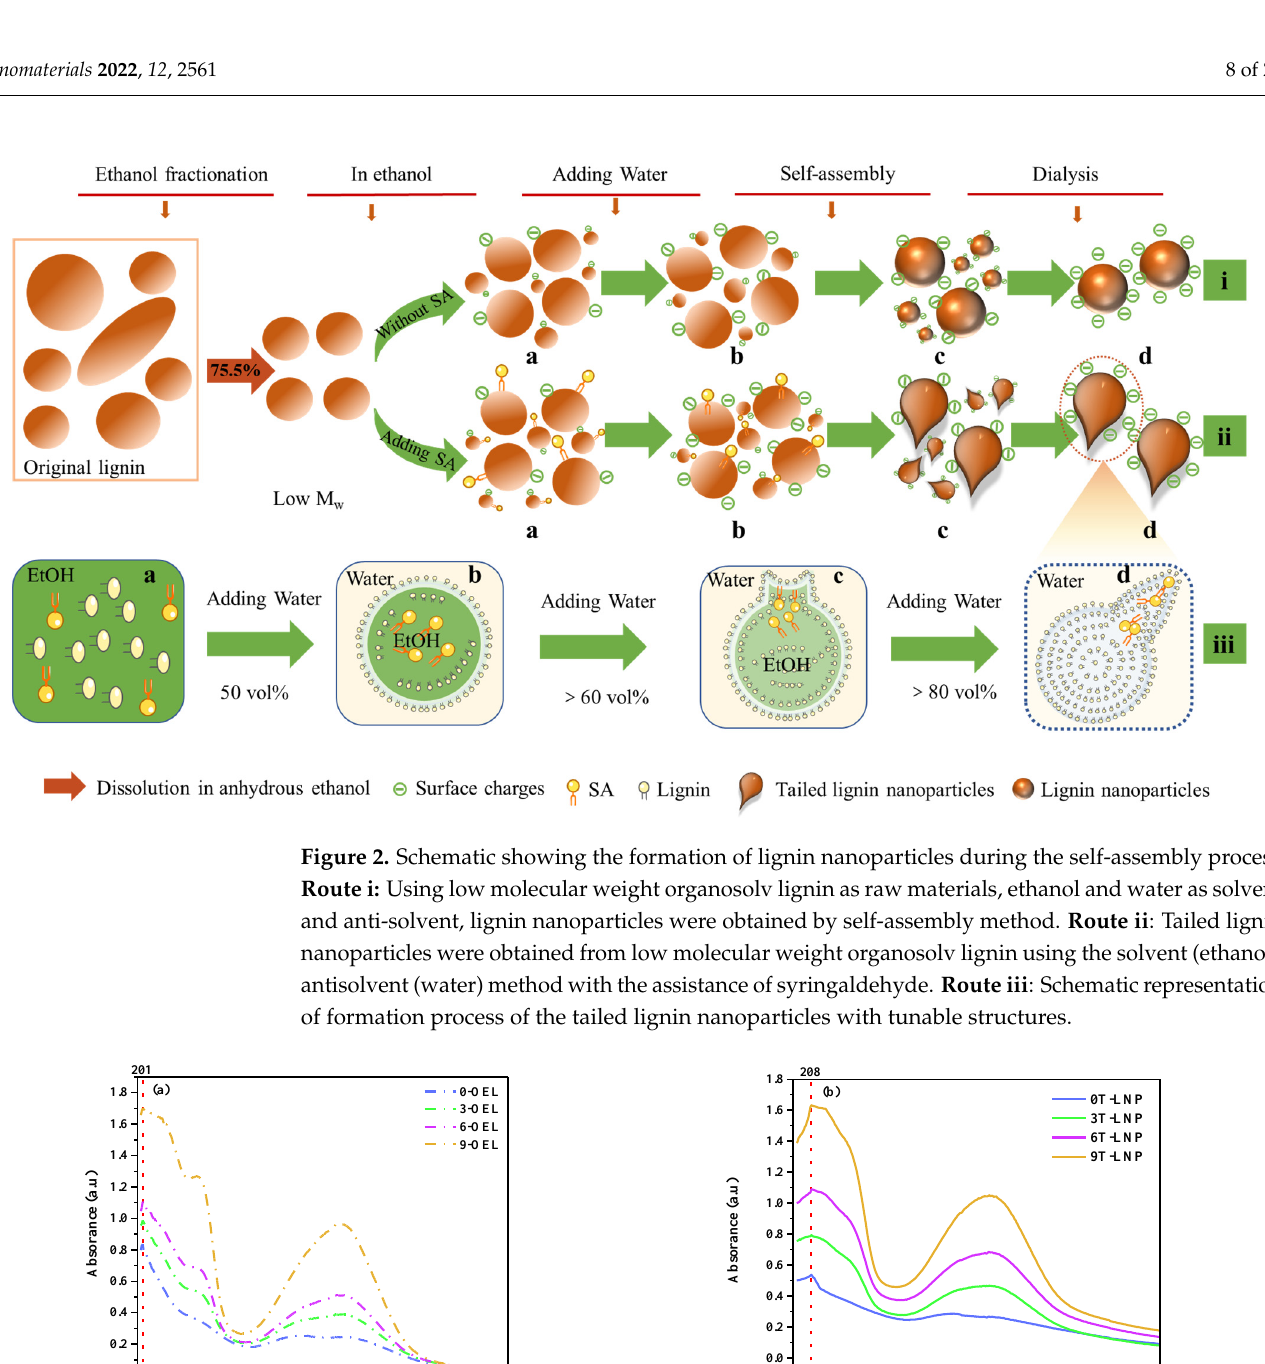
Figure 3. ( a ) UV − vis absorption spectra of OELs and ( b ) T −